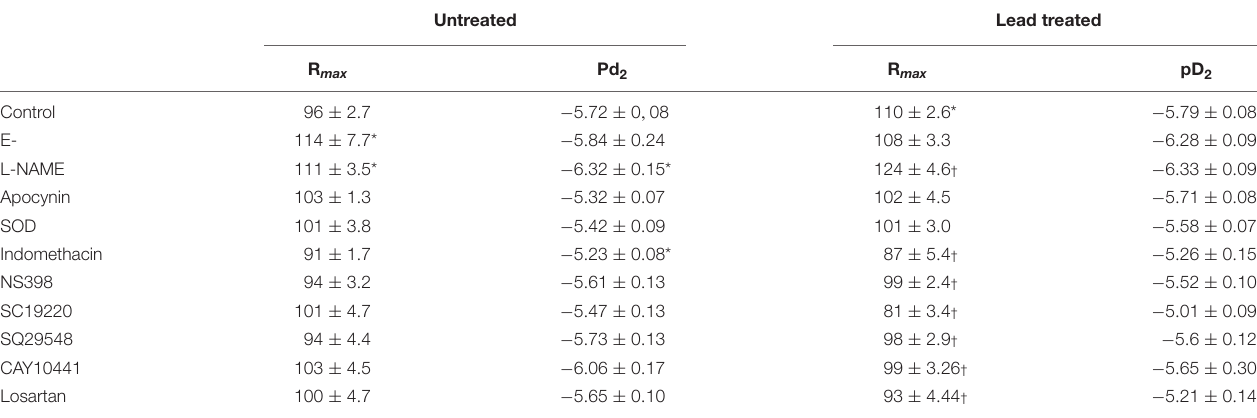
TABLE 1 | pD 2 and the maximum response to phenylephrine in mesenteric segments from untreated rats and rats treated with lead with or without endothelium, L-NAME, apocynin, SOD, indomethacin, NS398, SC19220, SQ29548, CAY10441, or losartan. Untreated Lead